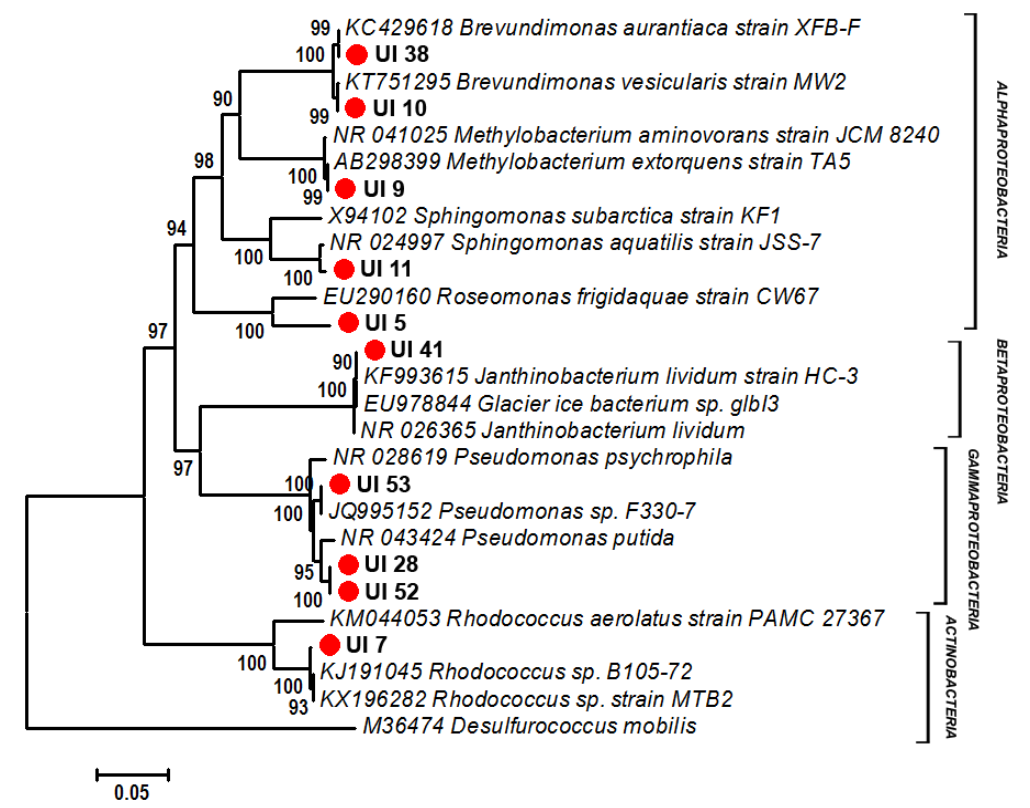
Рис. 6. Филогенетическое дерево нуклеотидных последовательностей гена 16S рРНК бактерий из подледных сообществ оз.